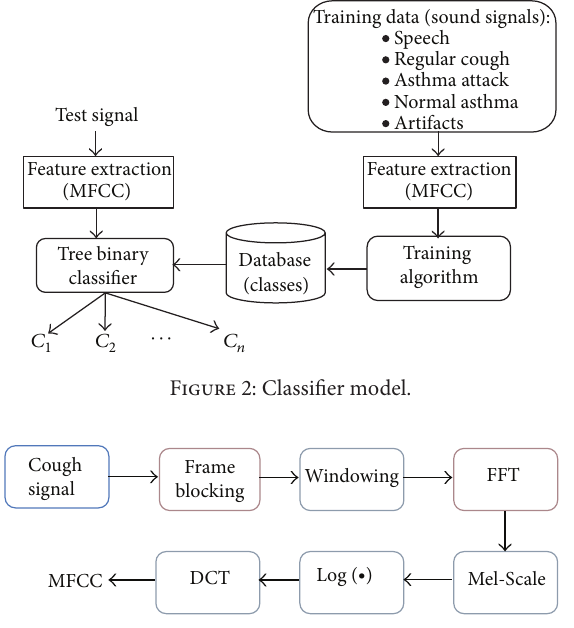
Figure 3: Block diagram of feature extraction process using MFCC